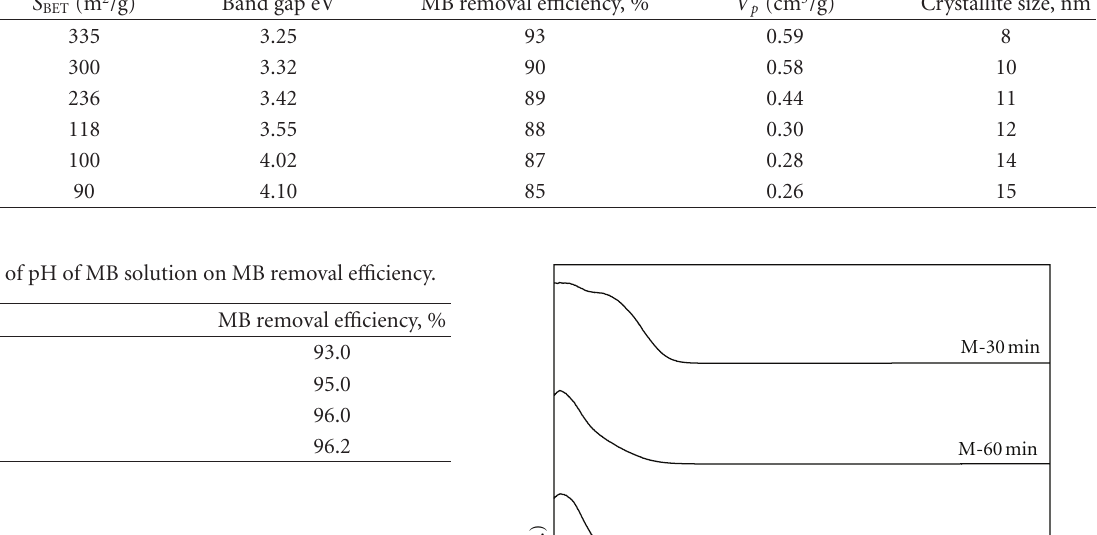
Table 6: E ff ect of MB concentration on MB removal e ffi ciency.